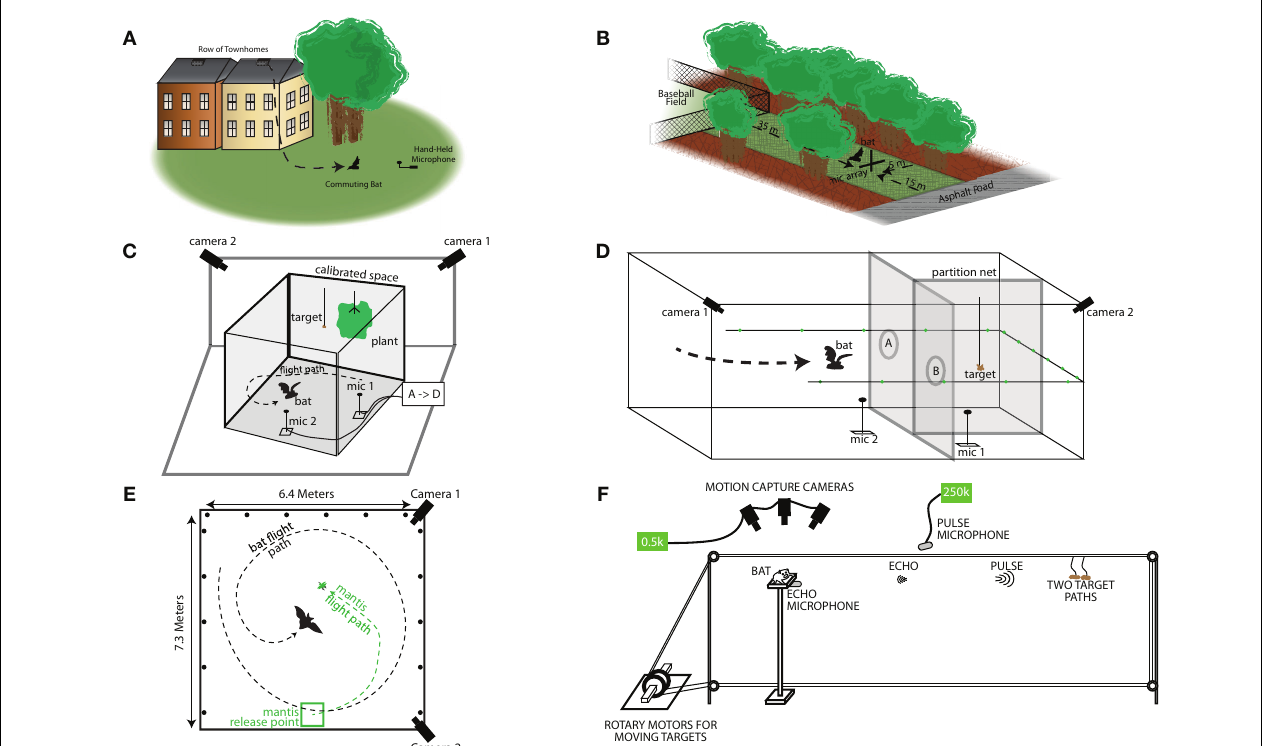
FIGURE 2 | Field and laboratory experimental setups. (A) Schematic of the Rockville, MD field site. Bats were exiting from behind a slatted vent near the roof on the side of a town home. This town home was at the end of a row of town homes that opened up onto a small field with a few trees. The bats’ vocalizations were recorded as they flew out of the house and onto the field. (B) Layout of the Lake Artemesia, MD field site. The recording site was a narrow corridor of grass between trees, bounded at one end by a baseball field and at the other by a paved road. The bats were recorded with a microphone array placed at the road-end of the corridor. (C) Laboratory setup for catching tethered mealworms in the presence of clutter. The clutter was a fern-like artificial plant hung from the ceiling, and mealworms were tethered to the ceiling at varying distances from the plant. Two cameras in the corners of the roomcapture3Dflighttrajectorydata,whilemicrophonesonthefloorrecorded sonar vocalizations. (D) Experimental setup for the net-hole experiment. The